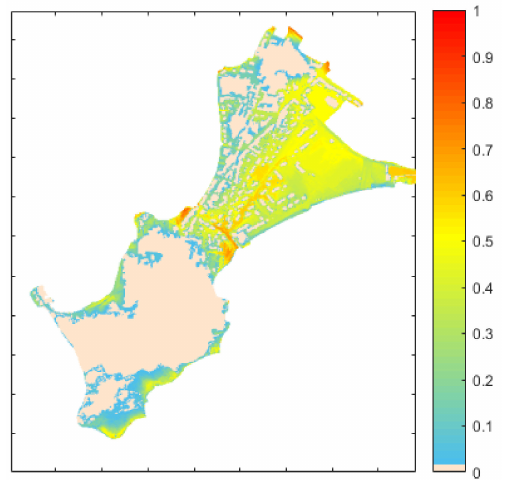
Figure 8. Ratio of the number of scenarios where the pixel is flooded to the total number of scenarios for the functional input grid